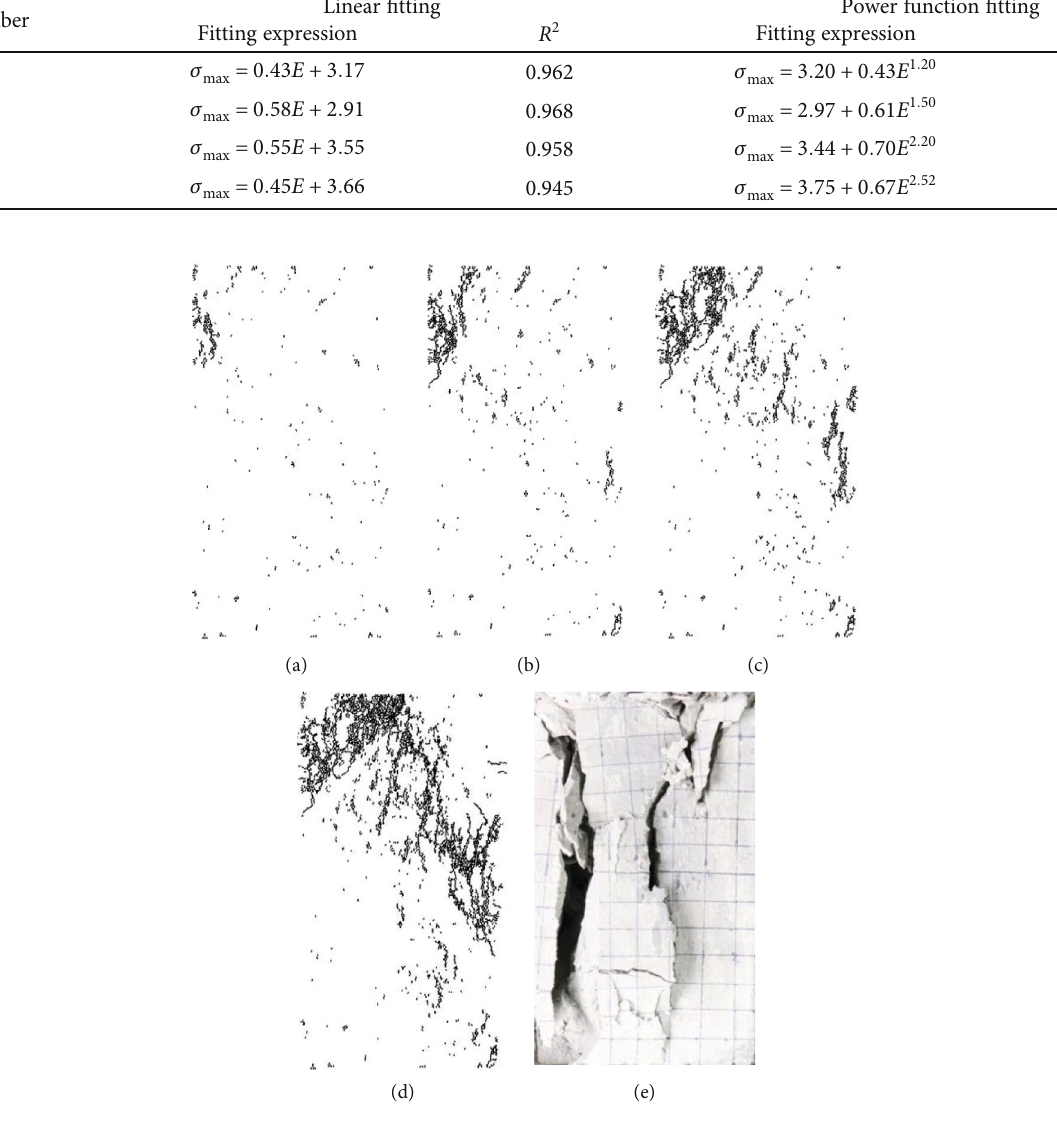
Figure 7: The process of crack initiation and development at the bend number of 0. (a) ε = 0 : 0067 . (b) ε = 0 : 0122 . (c) ε = 0 : 0183 . (d) ε = 0 : 235 . (e) Instable